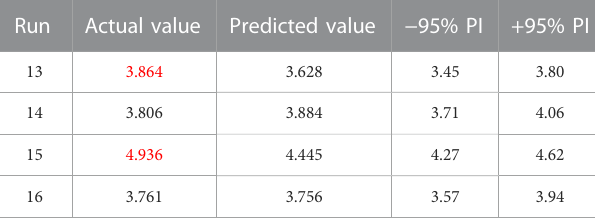
TABLE 9 Actual (experimental) values versus predicted values for the test and reserve